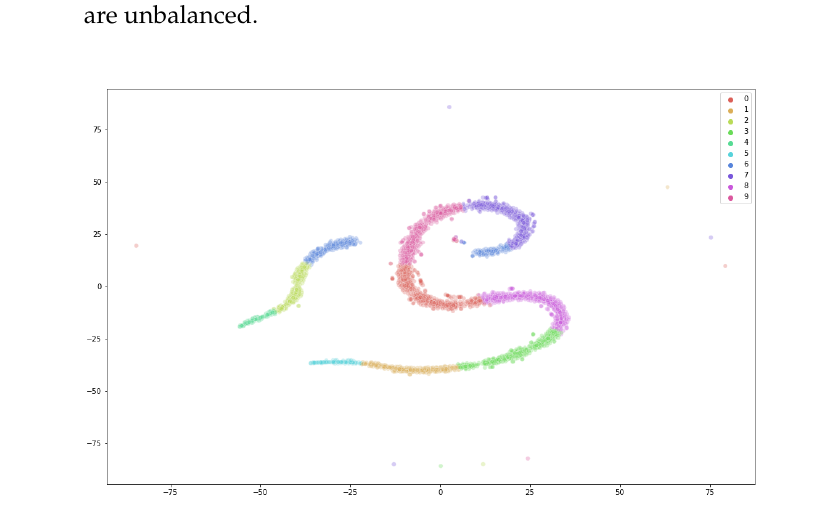
Figure 4. Visualization of 10 K-means clusters for E2006-dfidf using